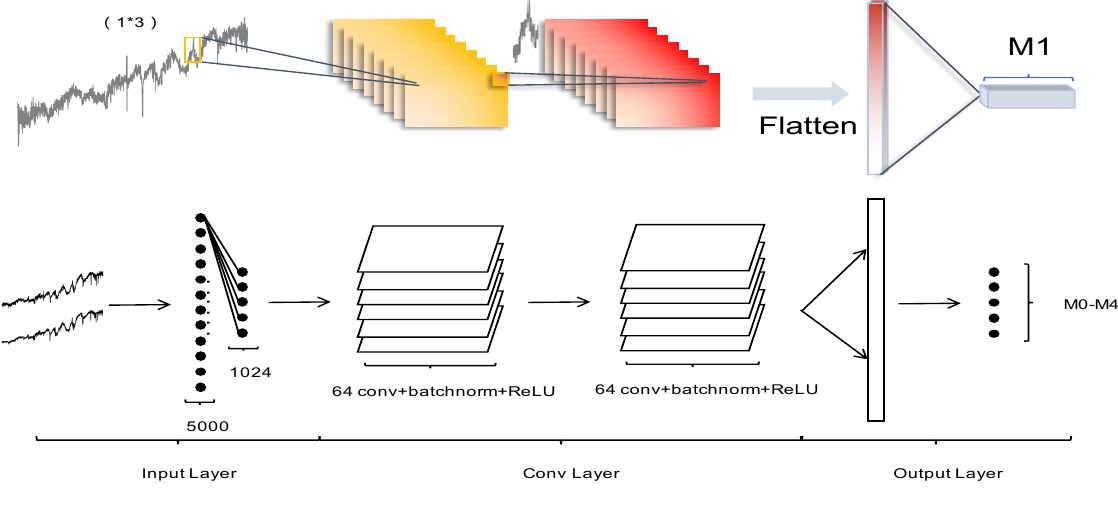
Figure 7. The network structure of